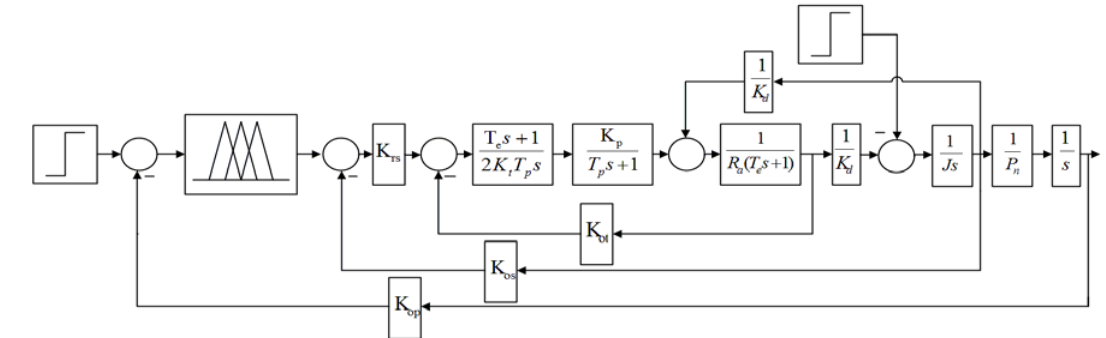
Figure 5. Transient process of system with conventional and fuzzy controllers (1 - system with conventional controller, 2- system with fuzzy controller)